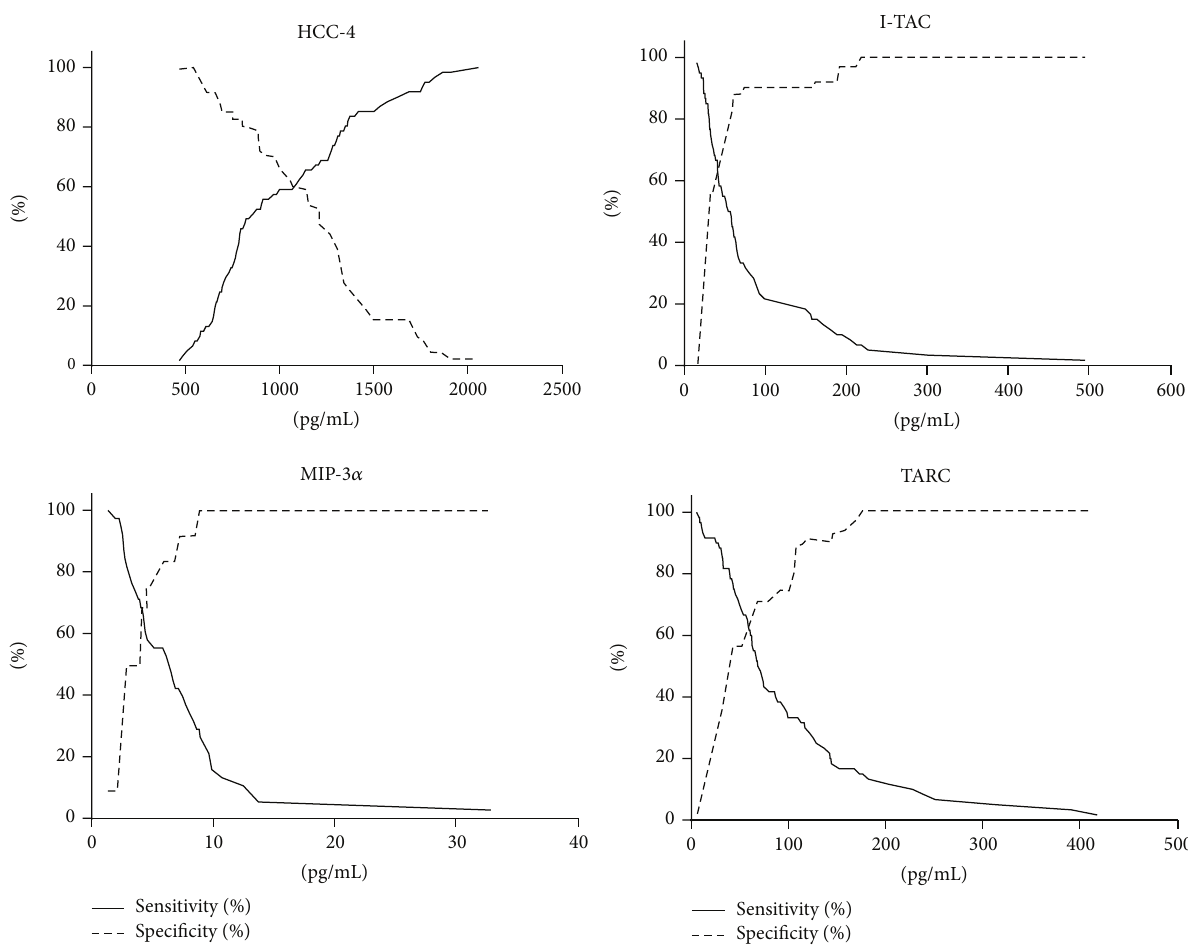
Figure 2: Sensitivity and specificity of markers HCC-4, I-TAC, MIP-3 𝛼 , and